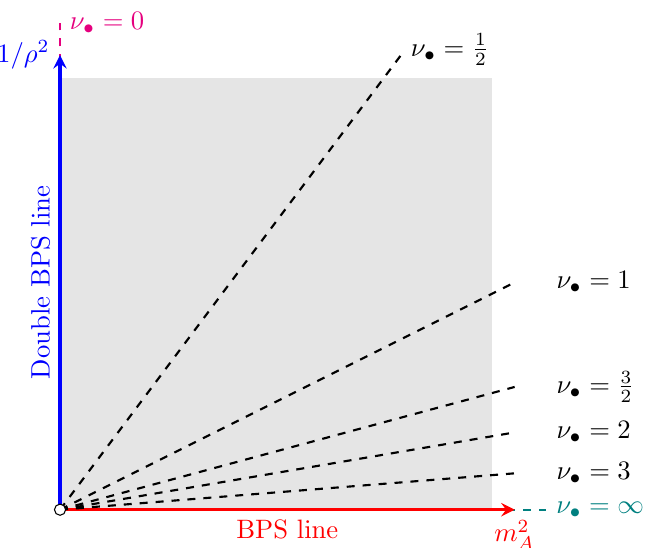
Figure 19 . The gray plane above, taken from (cid:12)gure 1, corresponds to the generalized BPS limit where m 2 0. We have reinterpreted the results of LMS as the dashed straight lines m 2 = A (cid:30) # (cid:23) ( (cid:23) + 1) =(cid:26) 2 in this plane, where LMS discovered the existence of a power series solution if (cid:23) (cid:15) (cid:15) (cid:15) is a positive half integer. LMS also studied other values of (cid:23) numerically in [10]. The BPS line (cid:15) corresponds to formally setting (cid:23) = , which is the same as sending (cid:26) . The double BPS 1 " 1 (cid:15) line corresponds to formally setting (cid:23) = 0, which is the same as sending m A 0. The work of # (cid:15) LMS seems to indicate that solutions along the dashed lines are special but we have not explored this. Note that those dashed lines interpolate between the two lines where we have exact analytic solutions. LMS found reasonable numerical solutions using a relaxation method with starting